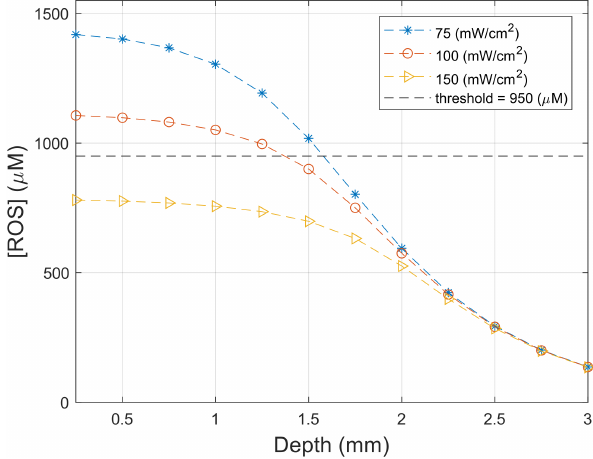
Figure 6. ROS concentration as a function of depth, calculated for different values of F ex ( z , λ ) , considering a total light dose of 150 J/cm 2 . The initial conditions and parameters of Tables 2 and 3 were